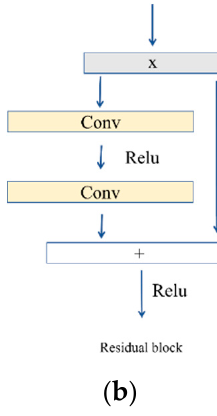
Figure 2. Residual U-Net structure. ( a ) U-Net structure and ( b ) residual block.